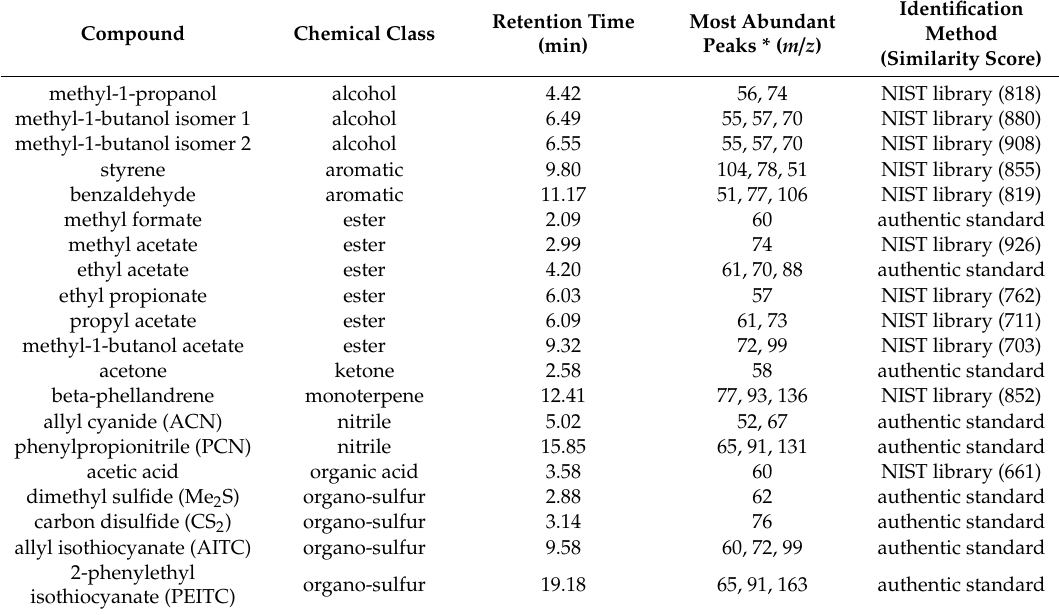
Table 2. Volatile organic compounds (VOCs) identified in the headspace of endophytes of horseradish or soil fungi growing on horseradish extract medium, detected by headspace GC-MS. Similarity score was obtained from a sample that contained the compound of interest with the best signal-to-noise